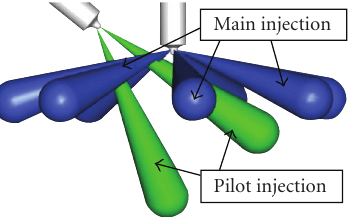
Figure 4: Schematic injection